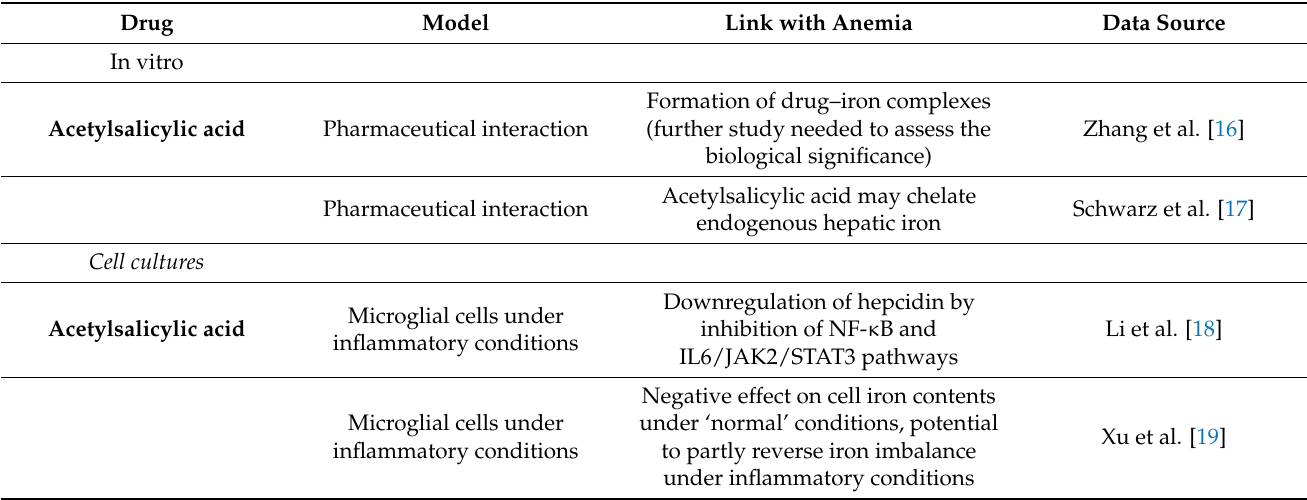
Table 1. The link between pharmacotherapy commonly used in transplantology and